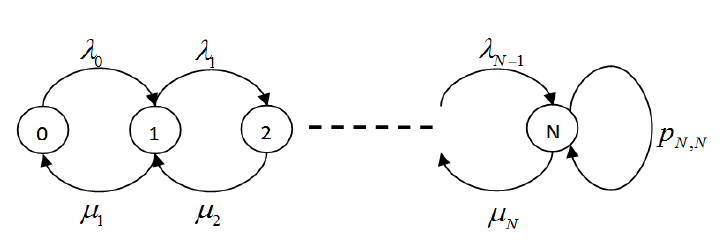
Figure 4. Typical M/M/1/N queue.